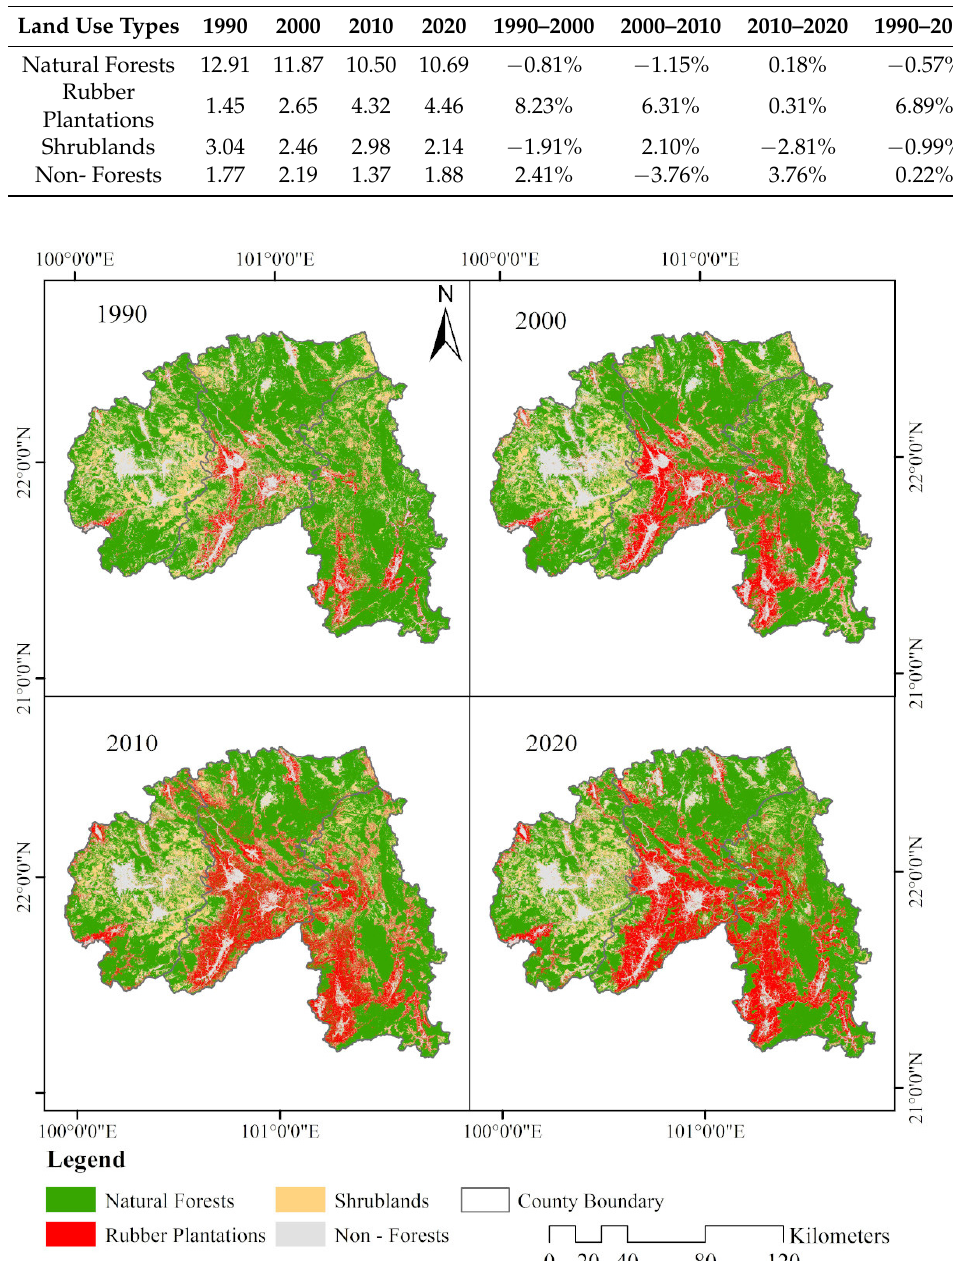
Figure 7. The rubber plantation and forest distribution in Xishuangbanna in 1990, 2000, 2010, and